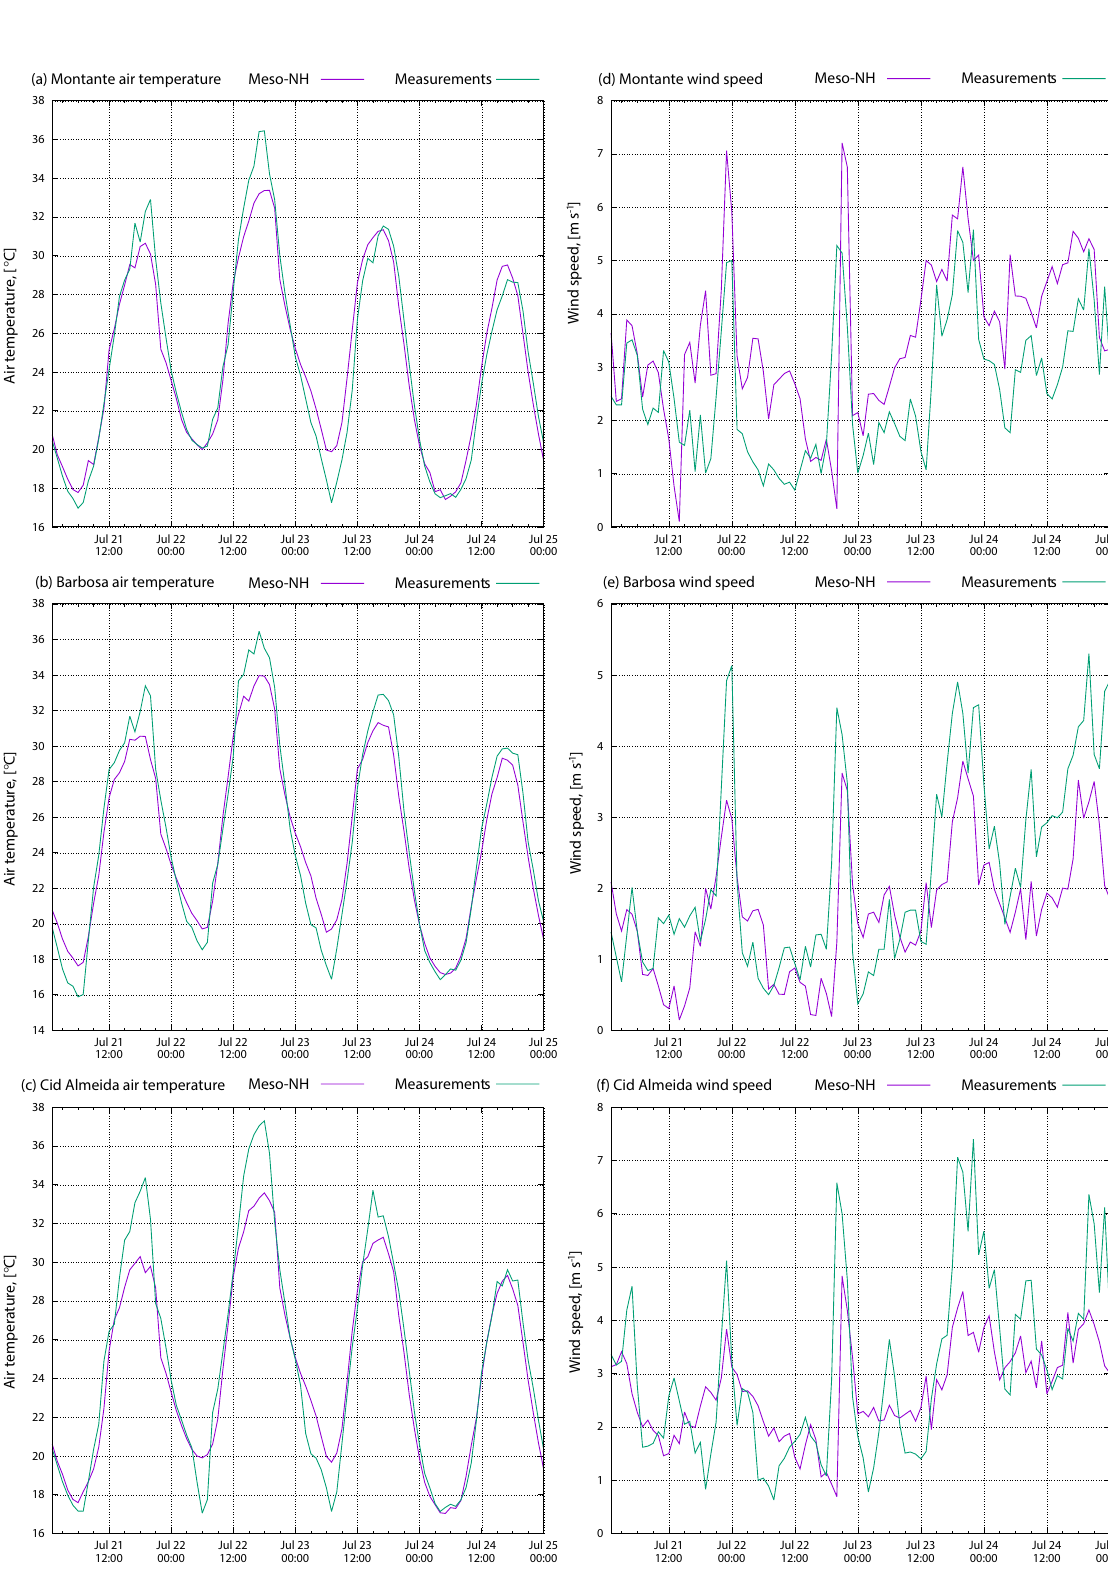
Figure 6. Observed and simulated air temperature and wind speed at 2m for ALEX stations: Montante platform (a, d) , Barbosa (b, e) , and Cid Almeida (c, f)